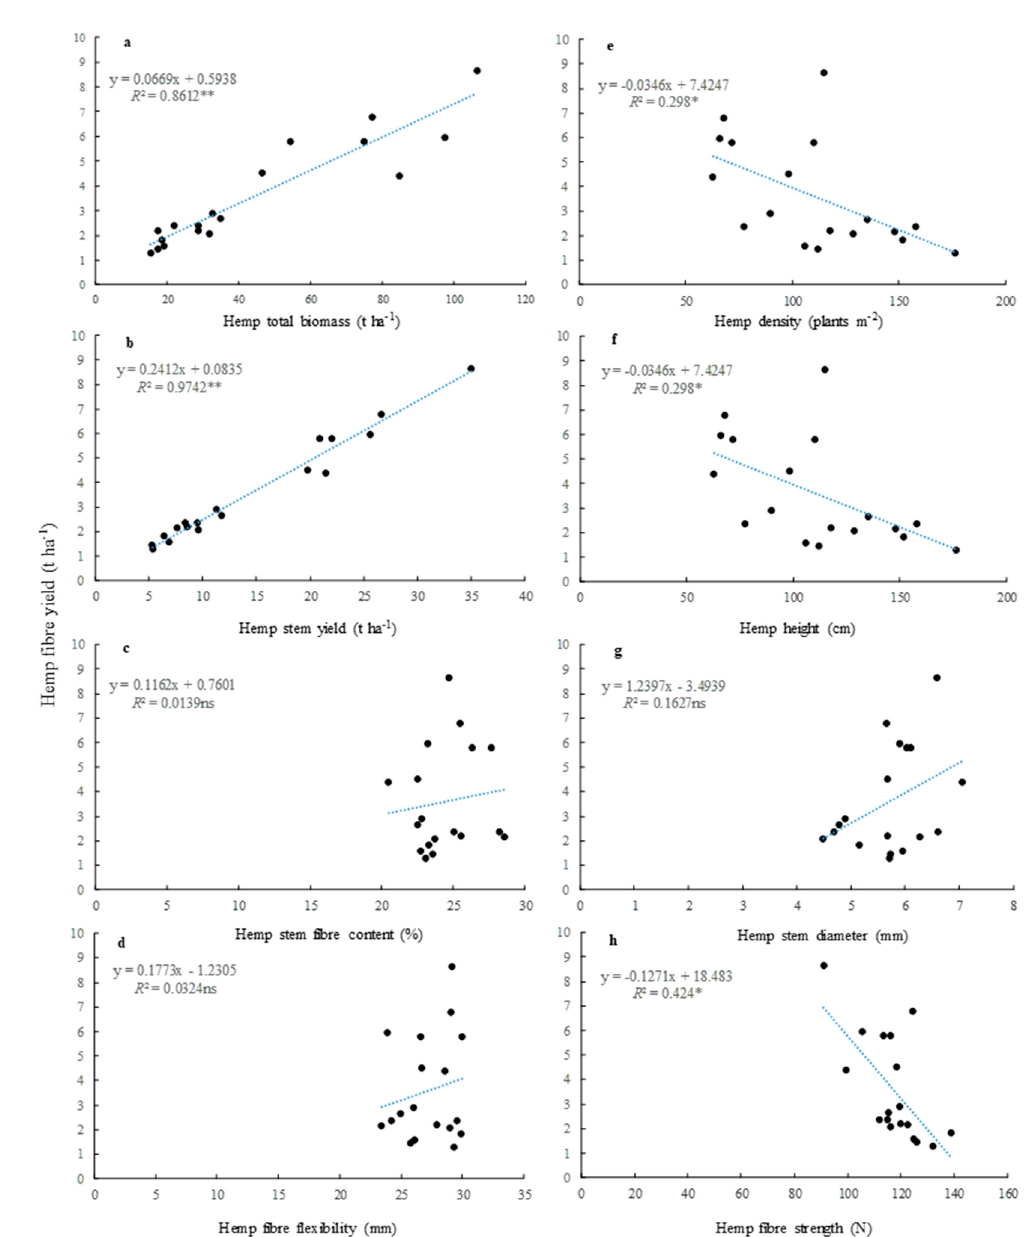
Figure 5. Correlations (linear regressions) between hemp fibre yield and ( a ) total biomass, ( b ) stem yield, ( c ) stem fibre content, ( d ) fibre flexibility, ( e ) plant density, ( f ) height, ( g ) stem diameter and ( h ) fibre strength of six hemp varieties. * p < 0.05, ** p < 0.01 and ns = no significance